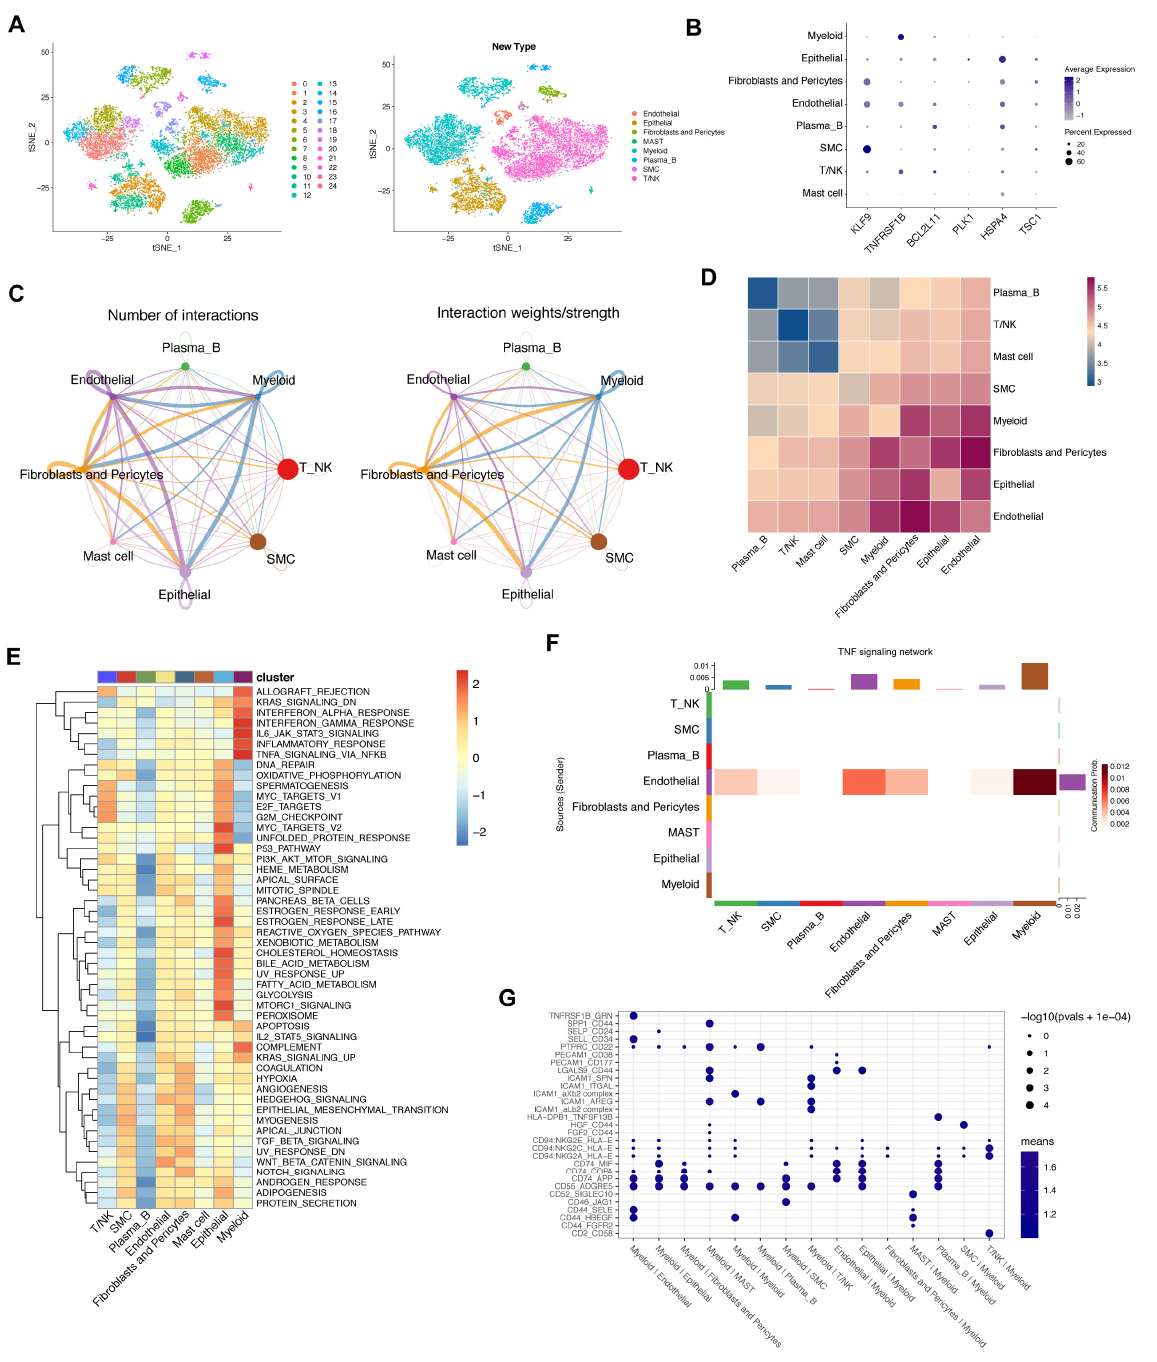
Figure 6. Cell–cell interaction analysis based on single-cell data. ( A ). A total of 12567 cells containing 3 primary gastric cancer samples in GSE163558 were clustered into different types of gastric cancer cells by “Seurat”. ( B ). The 6 prognostic necroptosis-related genes were expressed in different types of cells in gastric cancer. ( C , D ). Cell–cell interaction analysis was carried out via “CellChat” and “cellphonedb”. ( E ). GSEA analysis between different types of cells in gastric cancer. ( F ). Ligand– receptor analysis of TNF pathway in different types of cells in gastric cancer. ( G ). Connection probability of main signaling pathways in different types of gastric cancer cells.